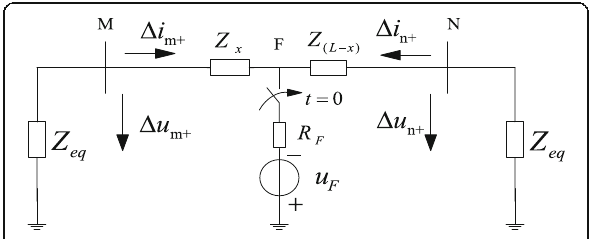
Fig. 2 Fault superimposed circuit for a positive-pole to earth